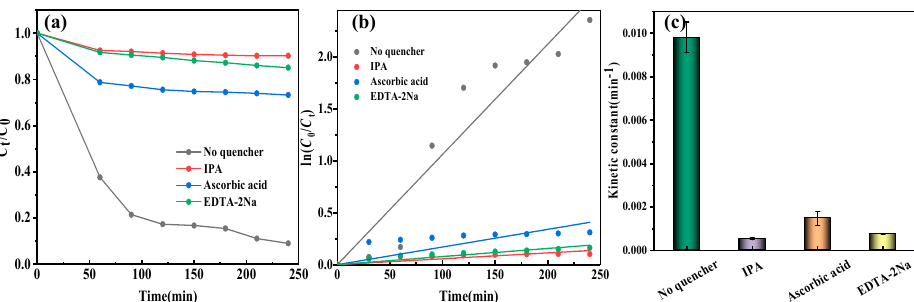
Figure 8. Radical trapping experiments: degradation efficiency of TC in the presence of different radical scavengers ( a ); the corresponding kinetic curves ( b ); and reaction rate constant k ( c ). (Reaction conditions: C (TC) = 20 mg/L, C (IPA) = 0.5 mg/L, C (Ascorbic acid) = 0.025 mg/L, C (EDTA-2Na) = 0.025 mg/L, no light in the fi rst hour, reaction time 240 min, the catalyst content is 5 g/L, LED UV lamp (425 nm) irradiated for 180 min).